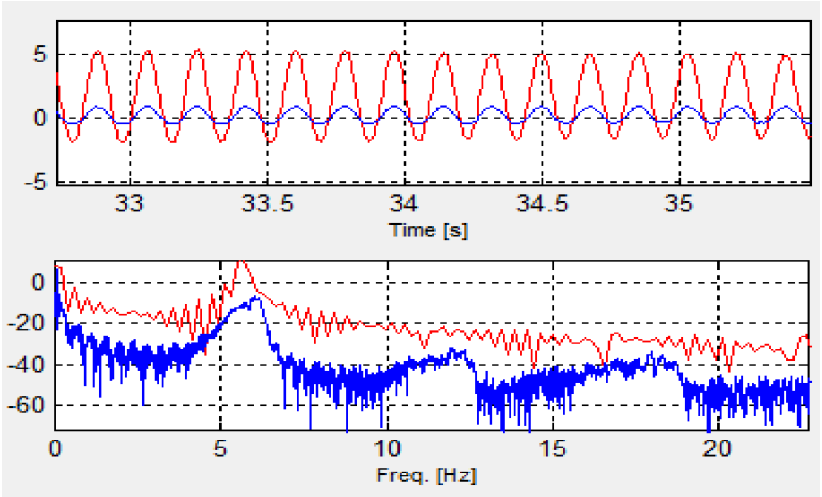
Figure 8. Estimation of vibrations of the target in Figure 7a over time ( above ) and spectral domain ( below ) before and after clutter compensation.